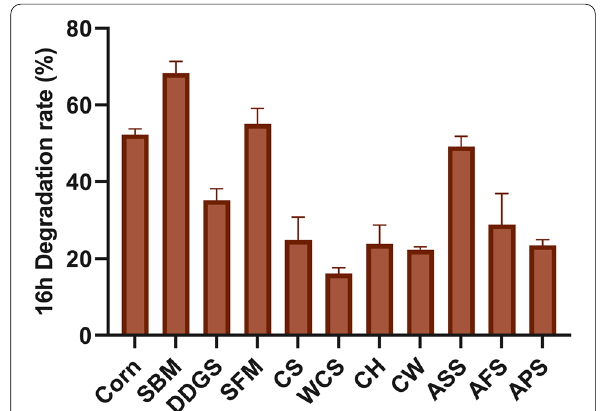
Fig. 2 The intestinal digestibility of RUP. SBM, soybean mean; DDGS, distillers dried grains with soluble; SFM, sunflower meal; CS,